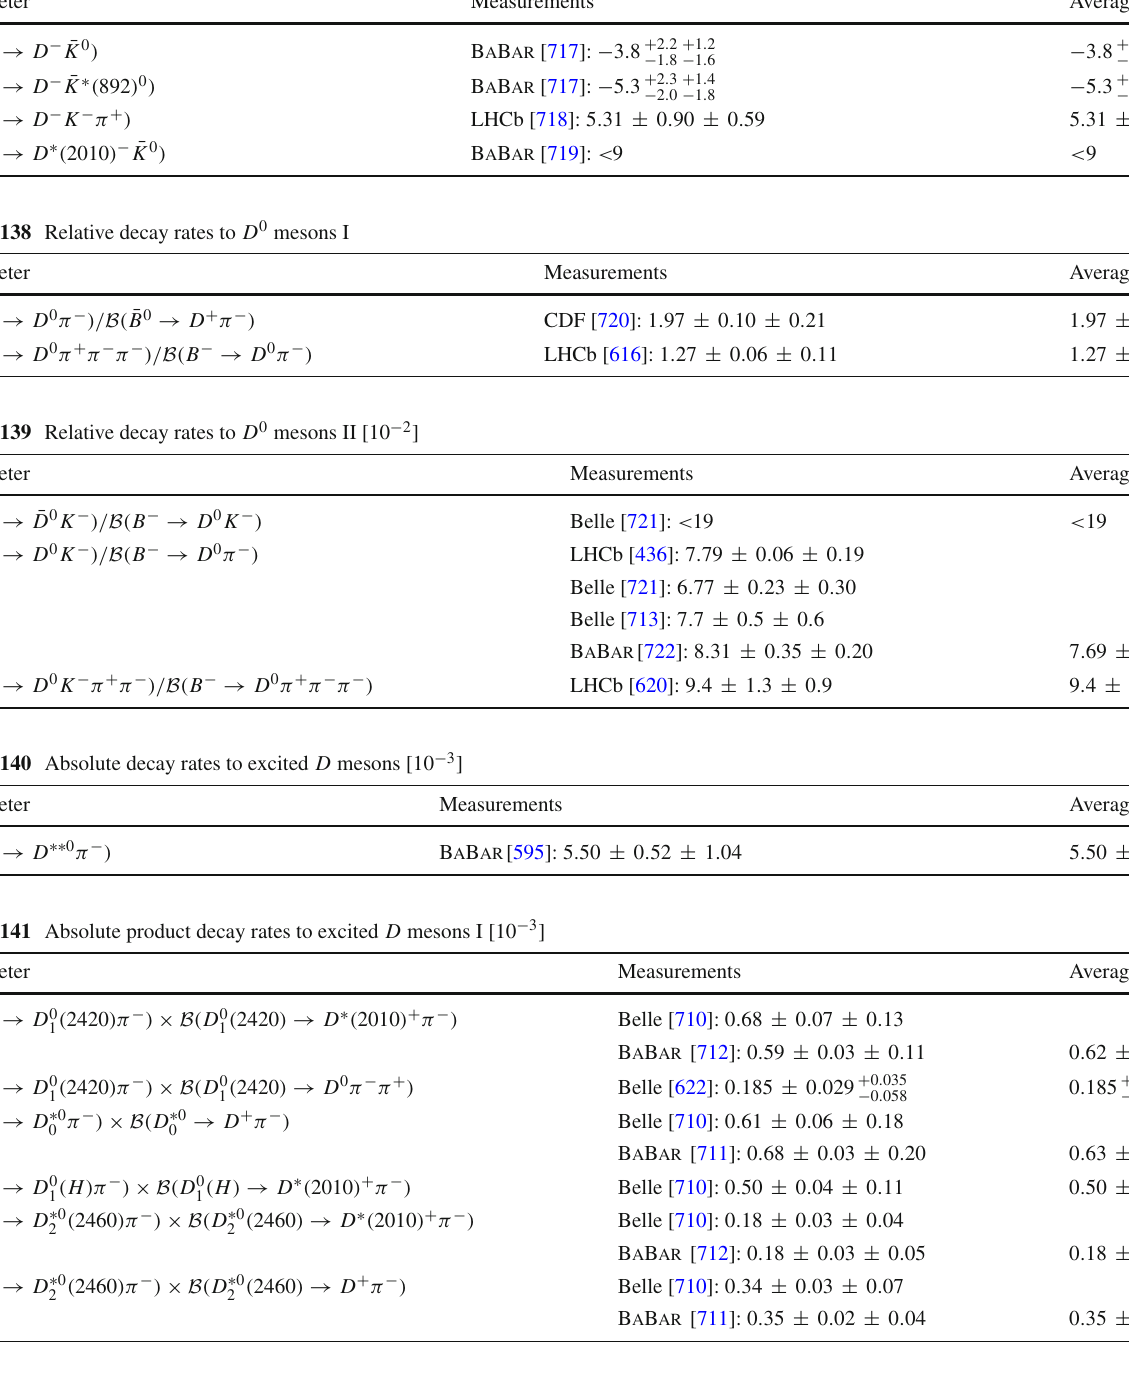
Table 137 Decays to a D ( ∗ ) − meson and a neutral kaon or a kaon and a pion [ 10 − 6 ] Parameter